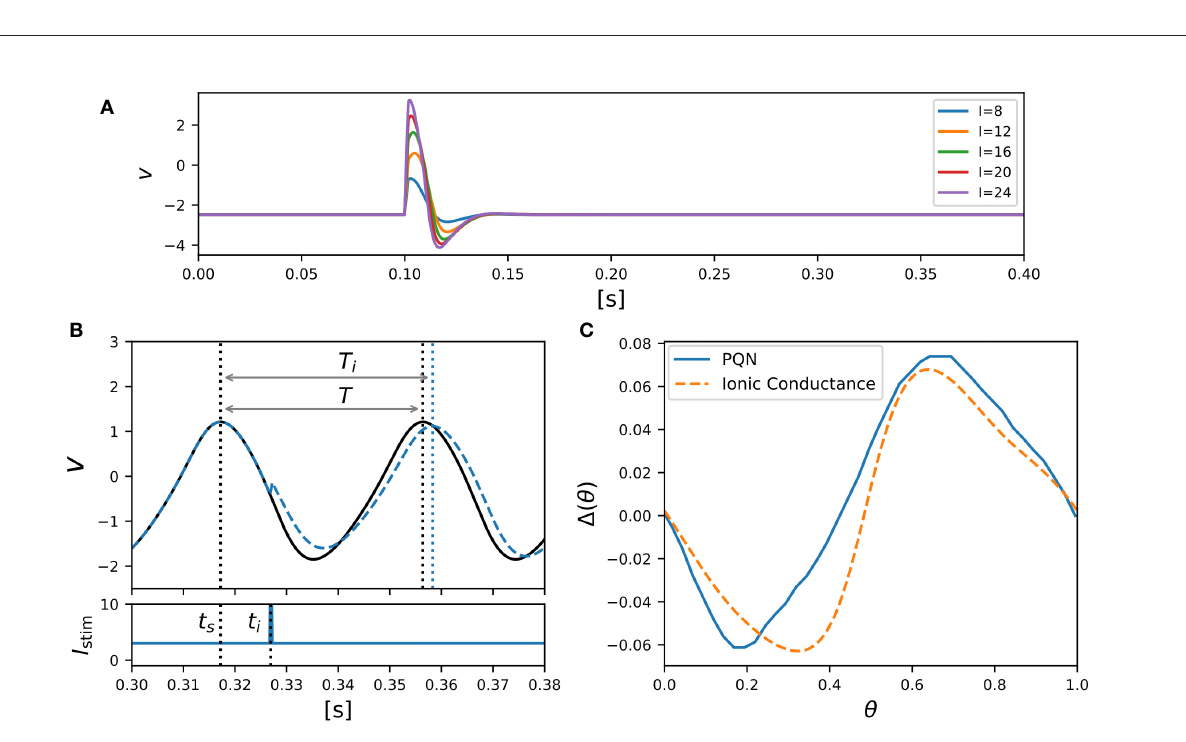
bursts become shorter. Both models in the PB mode